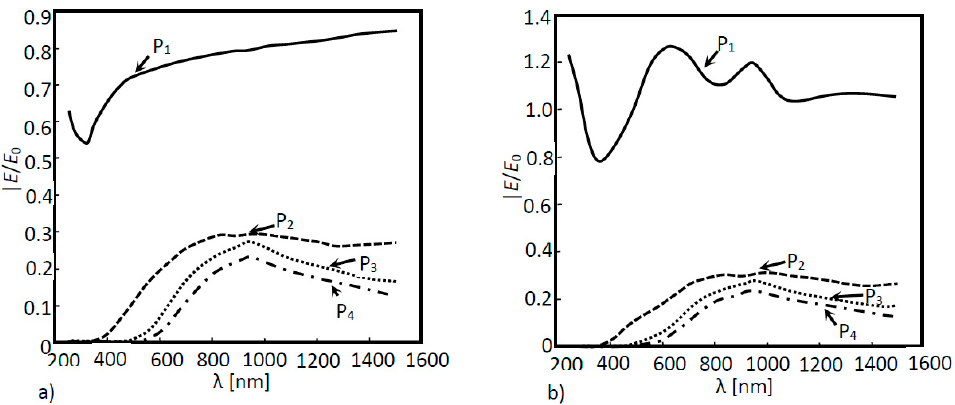
Figure 4. Normalized electric field as a function of the wavelength for a 2D a-Si solar cell structure. Measures were performed in four different positions: P 1 , P 2 , P 3 and P 4 for two different situations: ( a ) without a nanoantenna and ( b ) with a nanoantenna.